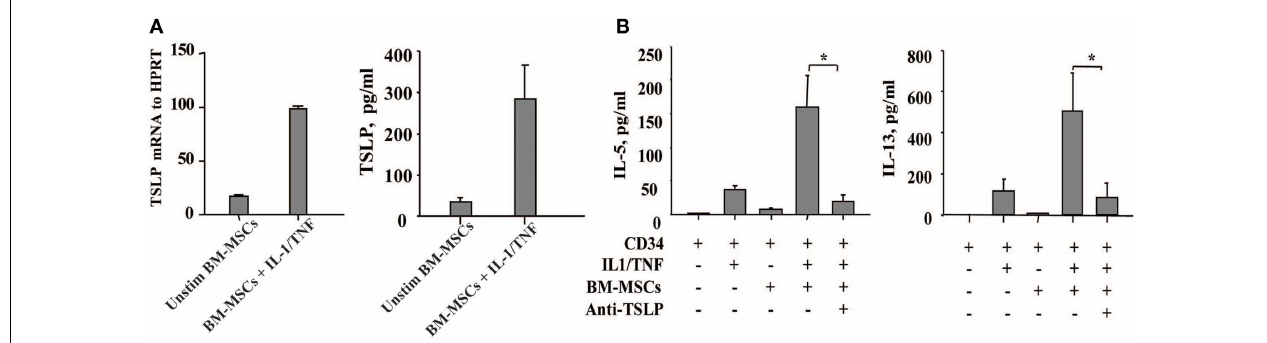
experiments. (B) Freshly isolated neonatal CD34 + cells were co-cultured overnight with BM-MSCs in the presence or absence of suboptimal concentrations of IL-1/TNF (1ng/ml of each) and neutralizing antibody toTSLP, as indicated. Isotype control antibody had no biological activity. Supernatants were assessed for IL-5 and IL-13 levels. Mean ± SEM of eight